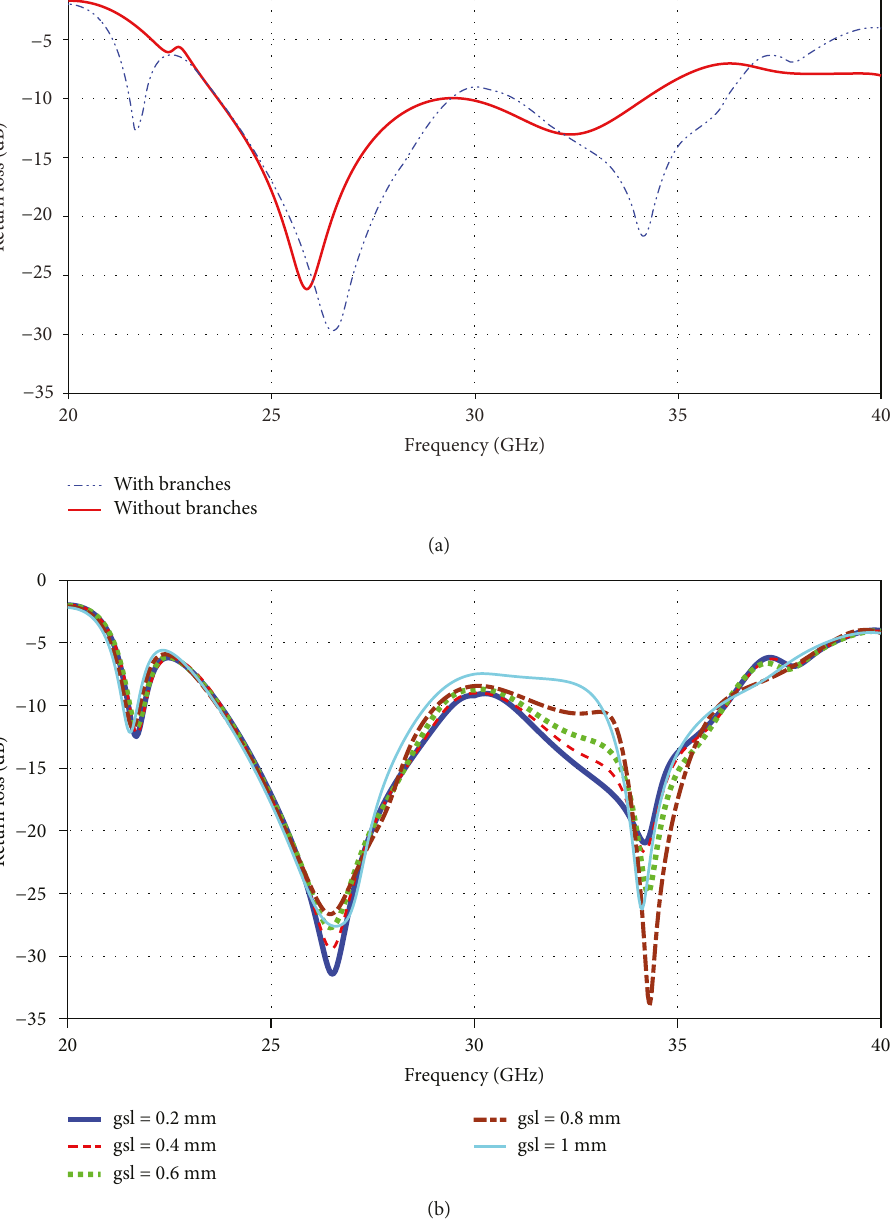
Figure 2: (a) Return loss of the proposed wideband antenna with and without branches, (b) parametric study of the small cuts on the ground